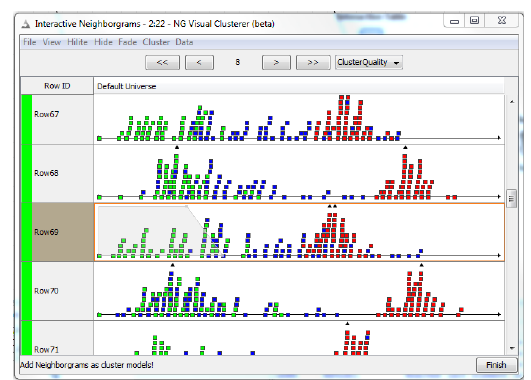
Fig. 12. The view of the visual fuzzy clustering node. Clus- ters are presented and fine tuned iteratively by the